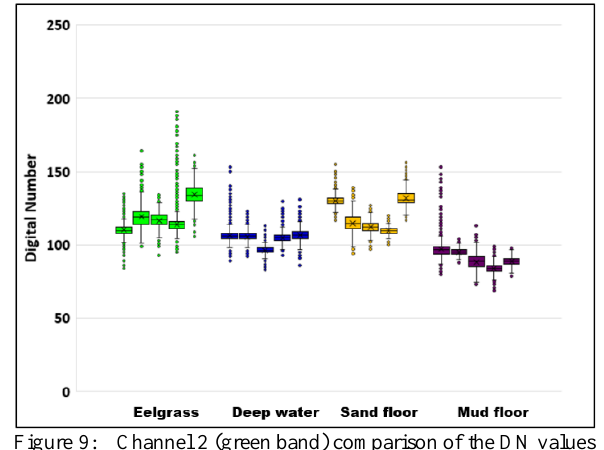
Figure 9: Channel 2 (green band) comparison of the DN values for the four classes in the PCI Geomatica RGB mosaic of Shediac Bay.